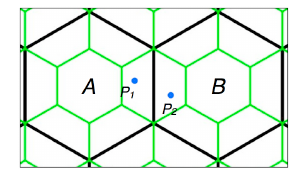
Figure 4(a). Point locations P and P lie in different coarser 1 2 precision cells (with indexes A and B respectively), but in the same cell at the next finer aperture 3 precision. Assuming a clockwise aperture 3 change in precision the points would have multi-precision quantization indexes of A6 and B3 respectively.